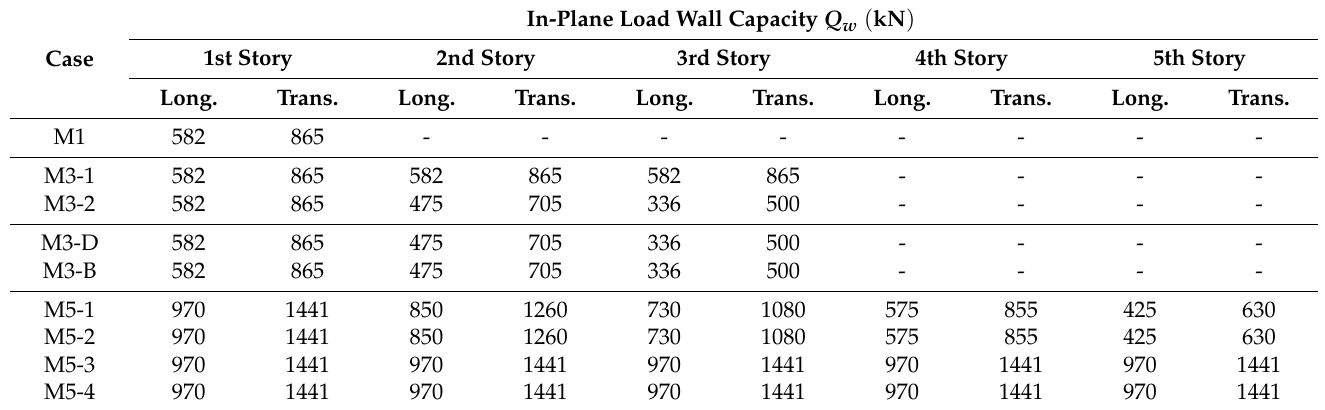
Table 4. In-plane wall capacity per story and analysis direction.